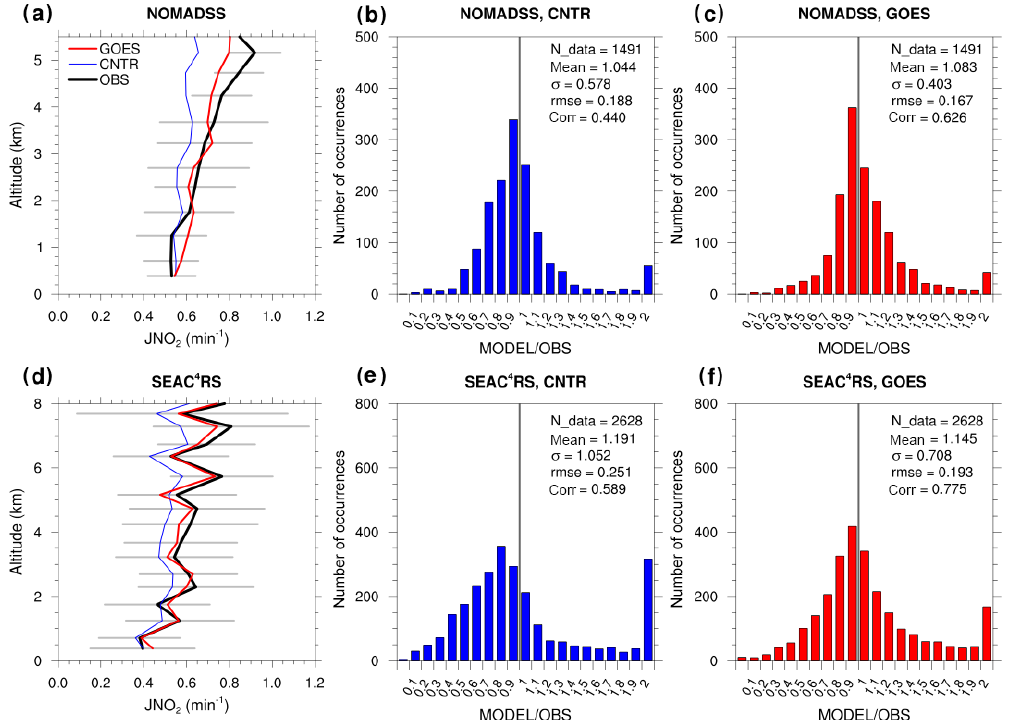
Figure 3. Model evaluation with 16 NOMADSS flights (top row) and with 21 SEAC 4 RS flights (bottom row). Note that only cloudy skies are considered. The comparison is performed for the averaged vertical profiles of J NO 2 for (a) NOMADSS and (d) SEAC 4 RS. The gray horizontal lines indicate the standard deviations from the observations. Histogram of the ratio of J NO 2 simulated by the model to J NO 2 observed (b) in the CNTR simulation and (c) in the GOES simulation for NOMADSS. Panels (e) and (f) are the same as (b) and (c) , respectively, but for SEAC 4